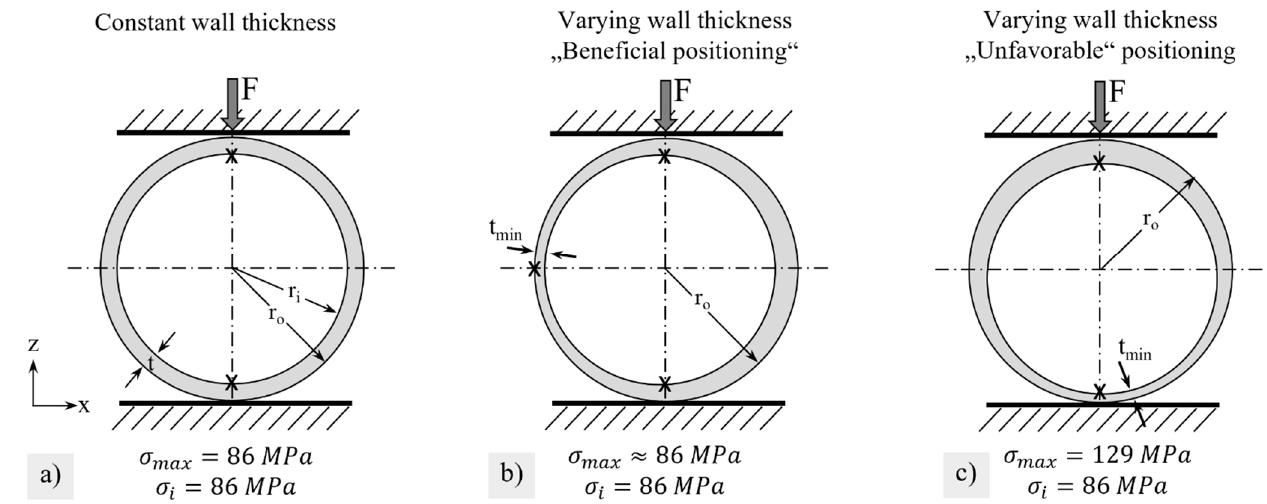
Figure 14. Schematic representation of how the positioning of brittle ring specimens with inhomogeneous wall thickness influences the stress σ max at failure and the fracture stress σ i determined in the test. Assumptions: l = 10 mm, F = 50 N, d o = 15.5 mm, t min = 750 µm. ( a ) constant wall thickness, ( b ) inhomogeneous wall thickness with beneficial positioning, and ( c ) inhomogeneous wall thickness with unfavorable positioning.